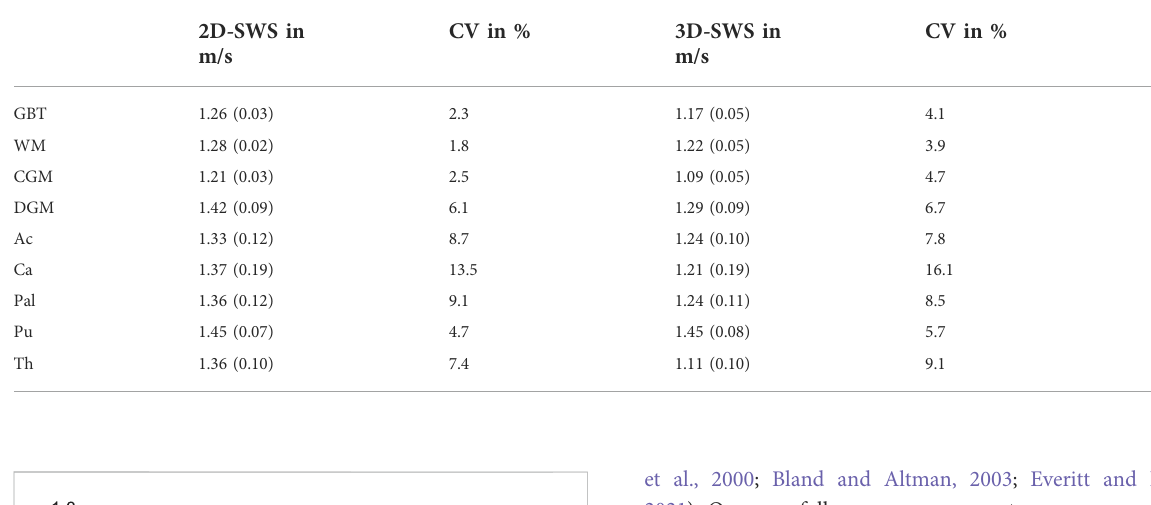
TABLE 1 Group mean values of SWS for 2D and 3D data processing and the coef fi cient of variation (CV) for all analyzed brain regions obtained in 31 brains (cross-sectional study): global brain tissue (GBT), white matter (WM), cortical gray matter (CGM), deep gray matter (DGM), nucleus accumbens (Ac), nucleus caudate (Ca), globus pallidus (Pal), putamen (Pu), and thalamus (Th). Standard deviations are given in brackets. In addition, region size is given.